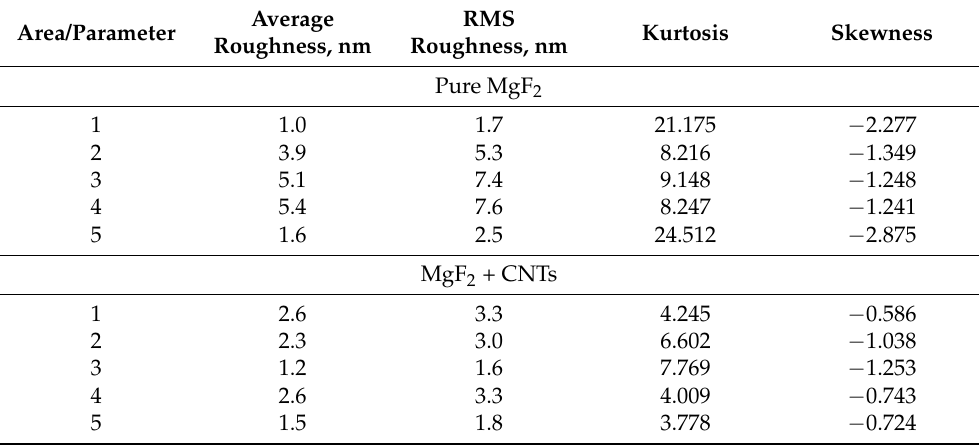
Table 3. Result of the roughness value changes for pure MgF 2 and for MgF 2 + CNTs.